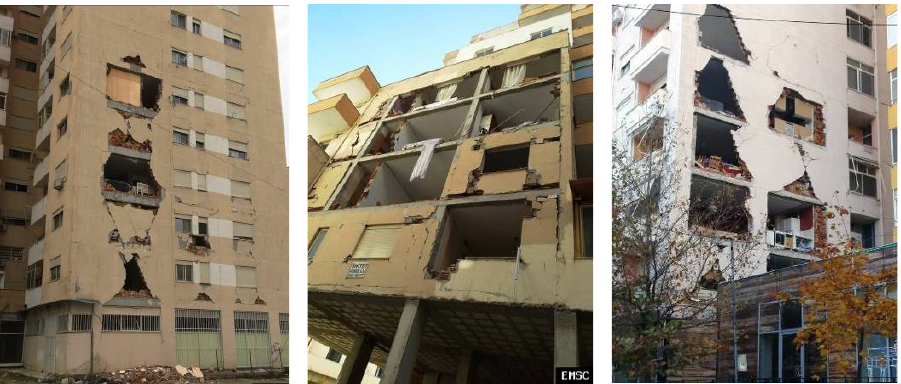
Figure 9. Out ‐ of ‐ plane collapse of unreinforced masonry infills (UMI) panles from RC frame structures due to earthquake excitation. tures due to earthquake